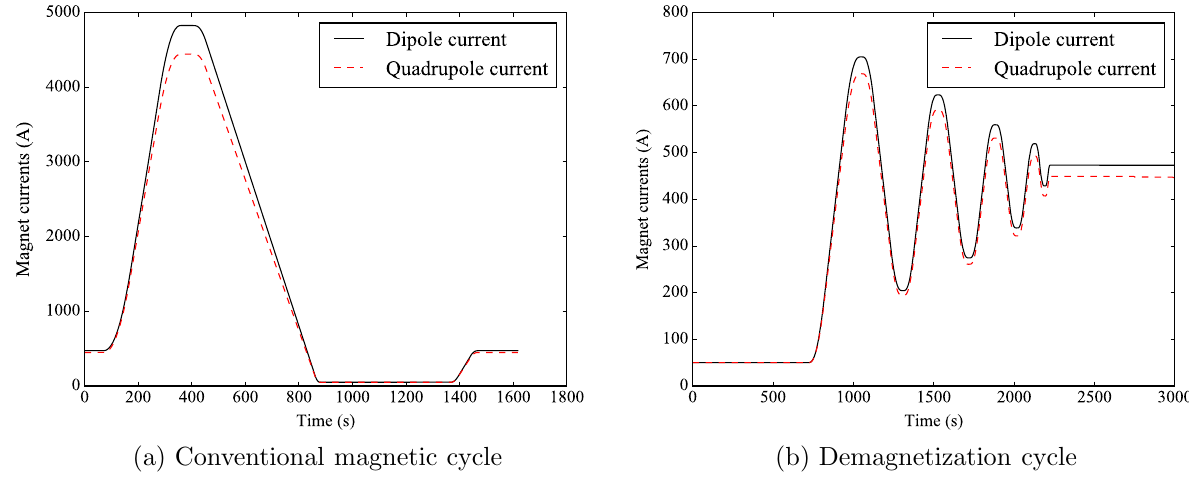
FIG. 16. The conventional magnetic cycle (a) and the demagnetization cycle (b) for beam operations at an RHIC main dipole current of 473 A. The demagnetization cycle removed a large fraction of the persistent current. Similar demagnetization cycles were implemented at all other BES-II energies.